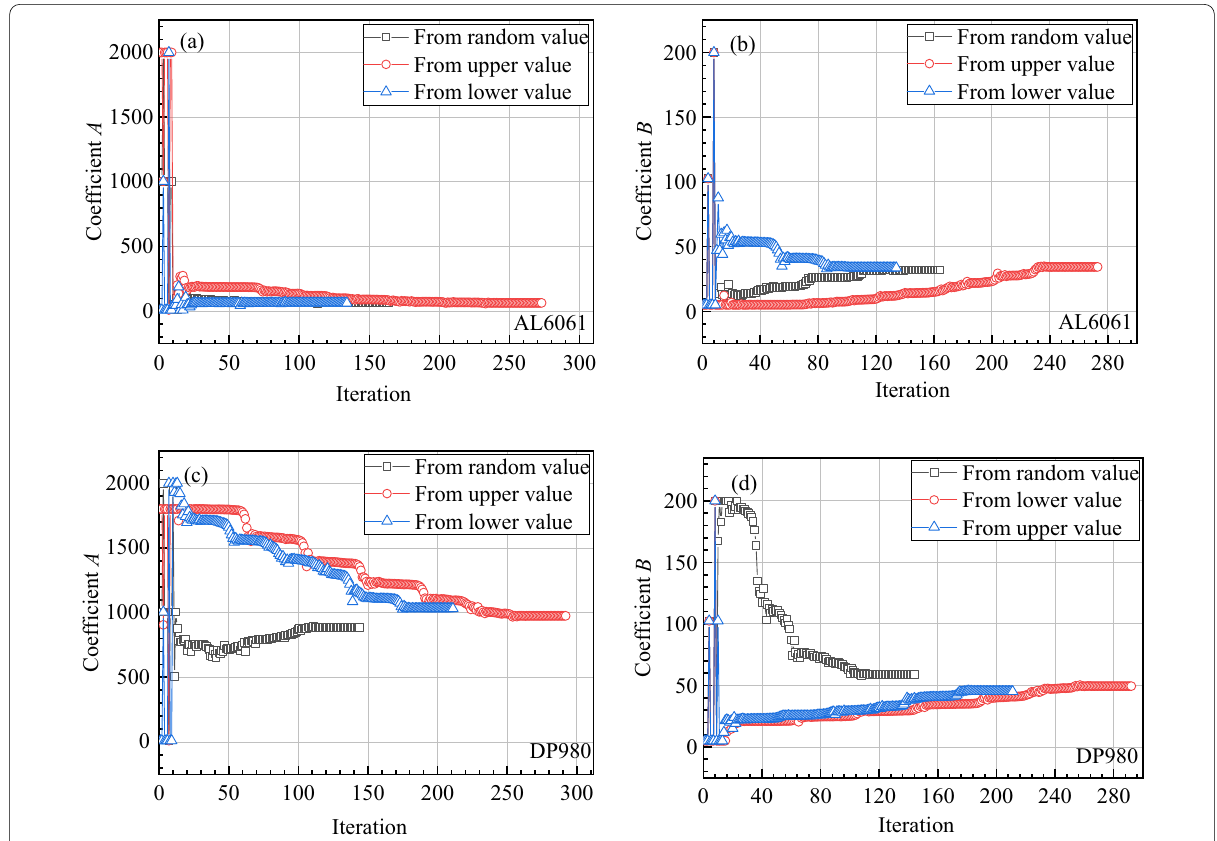
Figure 19 Learning process of Voce’s hardening parameters: a Parameter A of AL6061, b Parameter B of AL6061, c Parameter A of DP980, d Parameter B of DP980